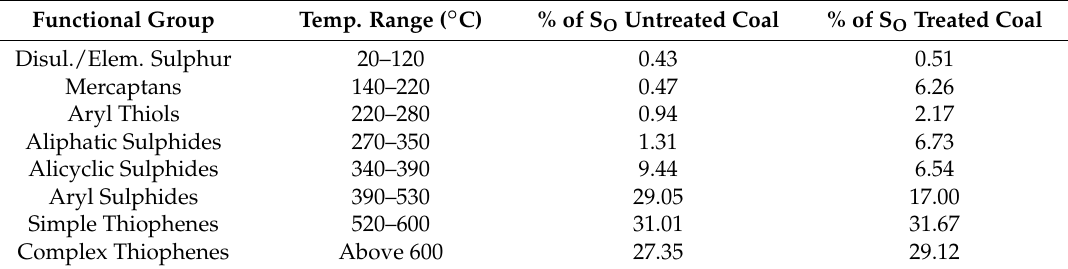
Table 5. Results for the TPR of treated and untreated harworth coal.